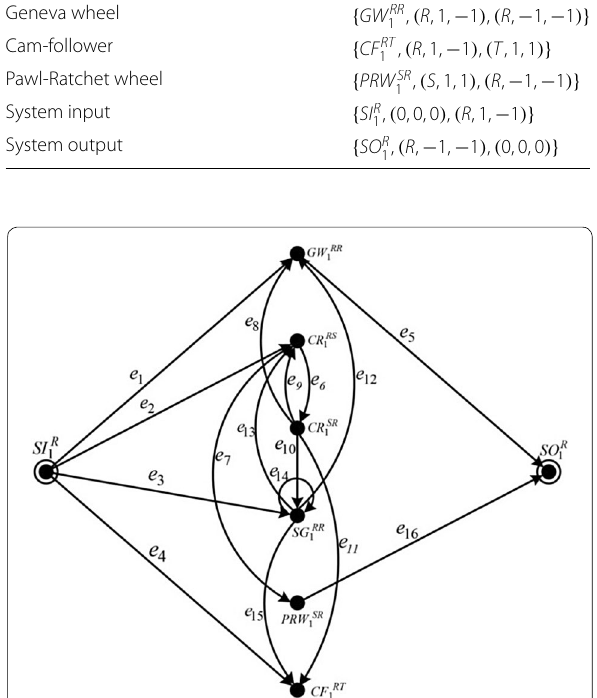
Figure 3 Graph representation of